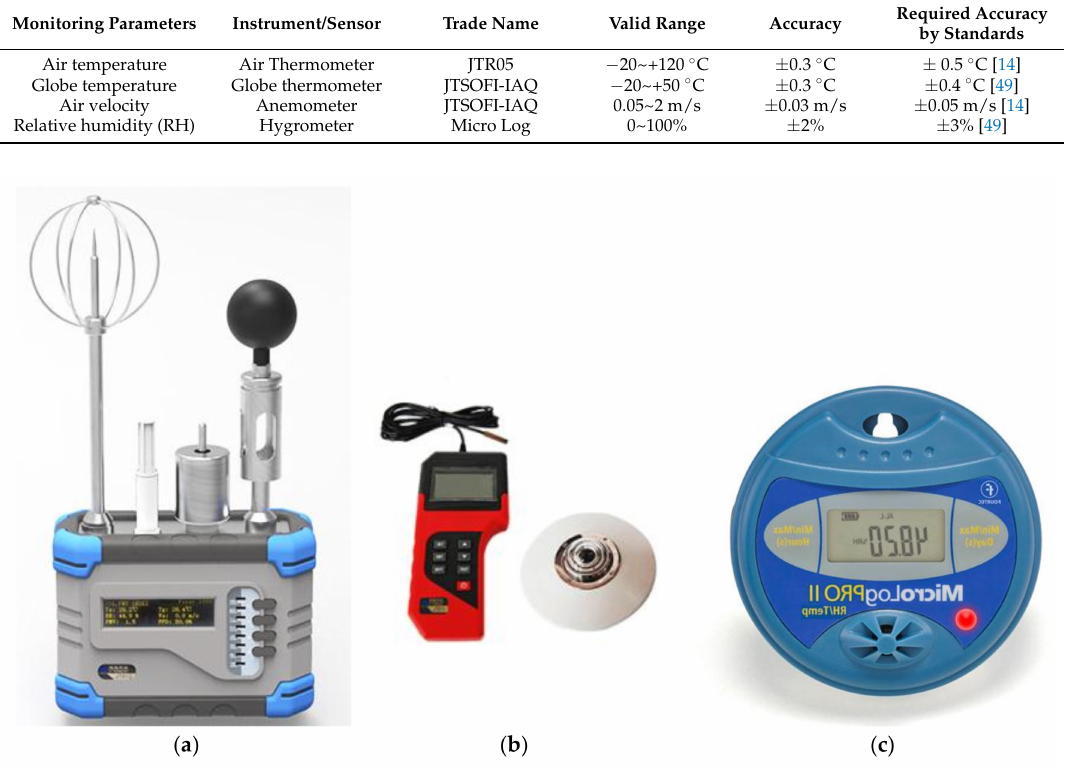
Figure 4. The measurement used during the study ( a ) JTSOFI-IAQ; ( b ) JTR05; and ( c ) Micro Log